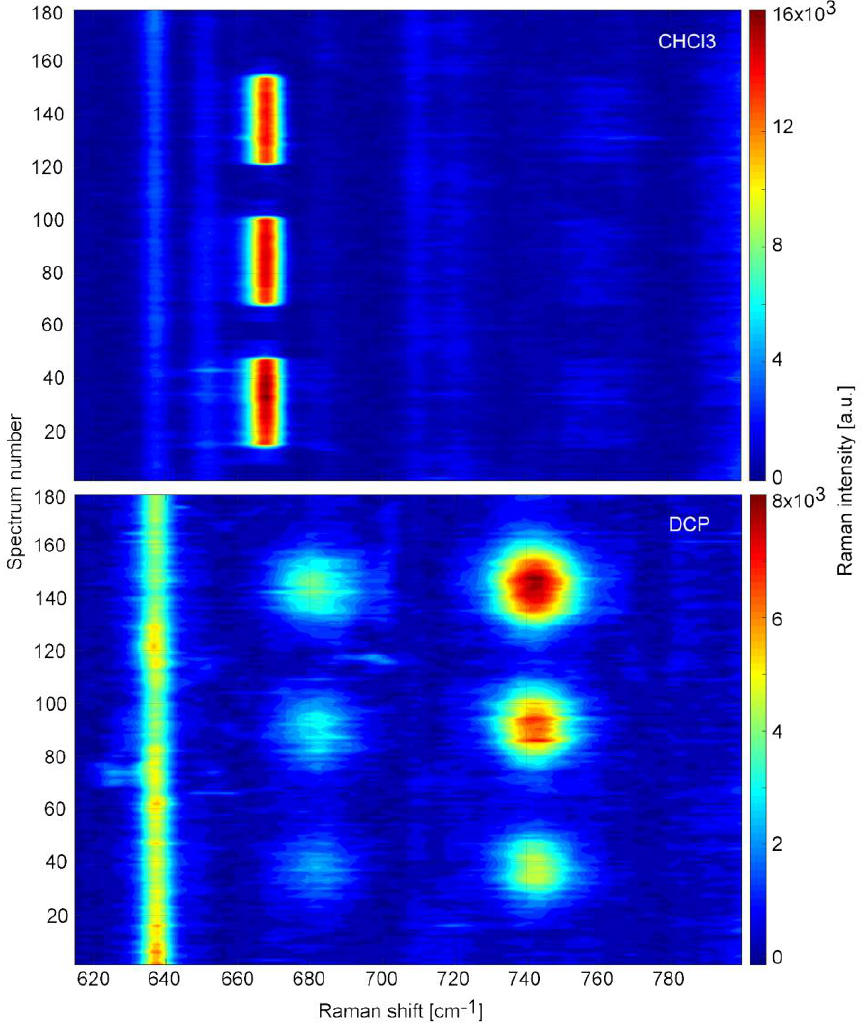
Figure 12. Spectral maps of 10 mM solutions of DCP (2,3-dichloropropanol) and CHCl 3 (trichloromethane) on SK307 during 3× repeated step gradient from 0 to 10 mM and back to 0 with 2.5 mM steps. Vertical axis represents time ordered spectra (15 s/spectrum). Horizontal axis represents the Raman shift. The intensity of Raman signal is